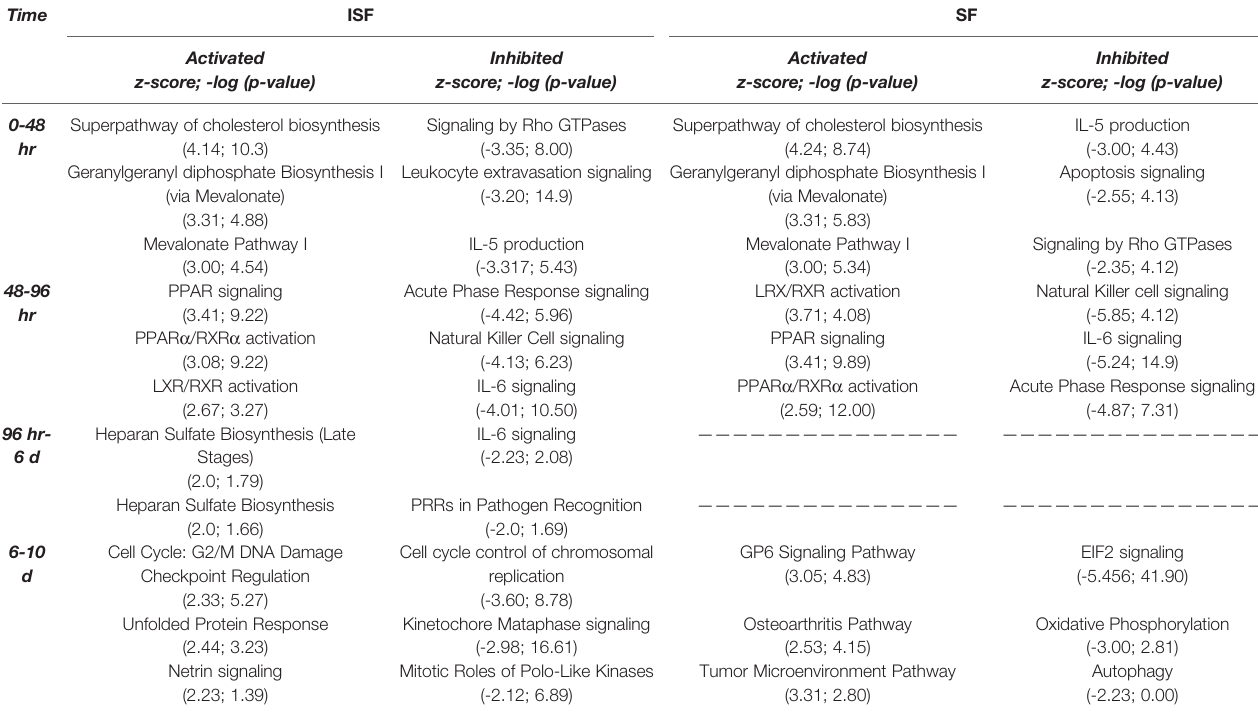
TABLE 1 | Top 3 most activated or inactivated pathways (Z-score > 2.0 or < -2.0; -log (p-value) > 1.3 = p>0.05) identi fi ed by IPA from DEGs between consecutive timepoints in SF and